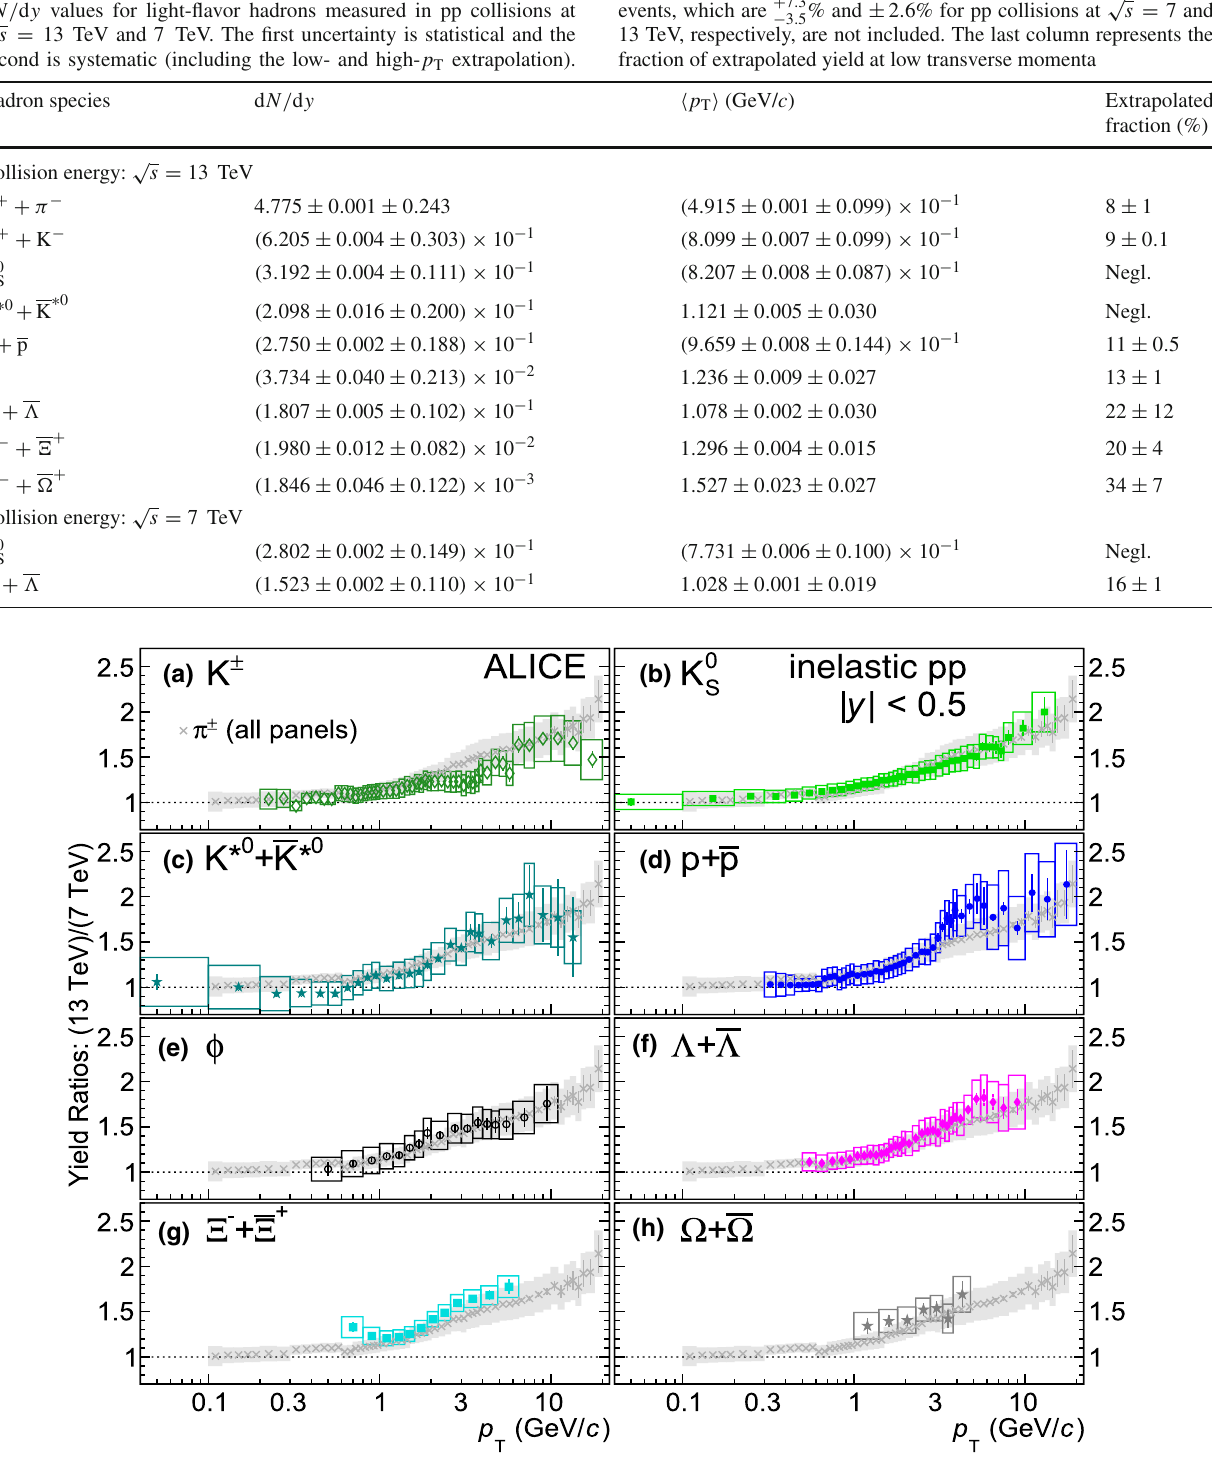
Fig. 6 Ratios of the transverse-momentum spectra of light-flavor hadrons in inelastic pp collisions at s = 7 TeV [25,27,60]. The ratio for π ± is shown in each panel